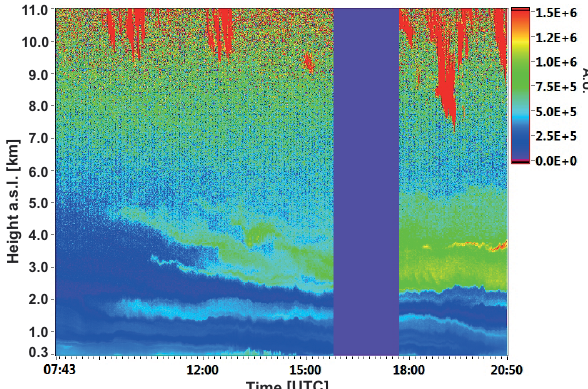
Figure 8. Saharan dust outbreak advecting dust particles between 2 and 6km height towards Limassol, Cyprus, on 23 May 2013. Range-corrected 1064nm backscatter signals (in arbitrary units, A.U.) are shown. Red features above 7km indicate ice clouds.